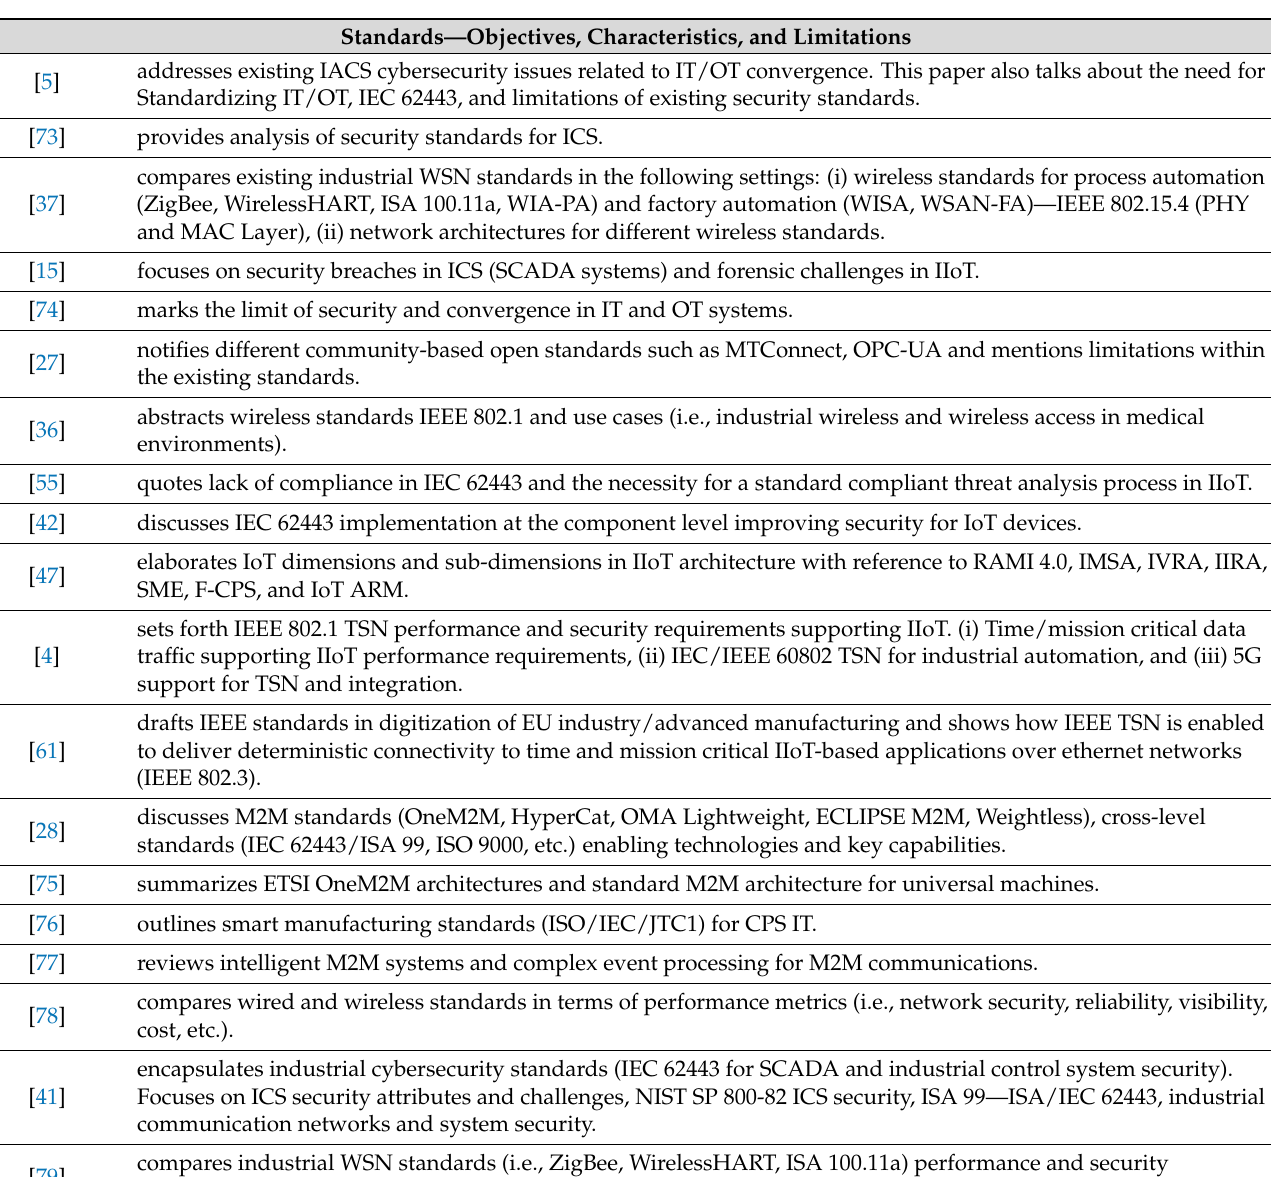
Table 3. Synopsis of different cybersecurity standards and threats in IIoT. Standards—Objectives, Characteristics, and